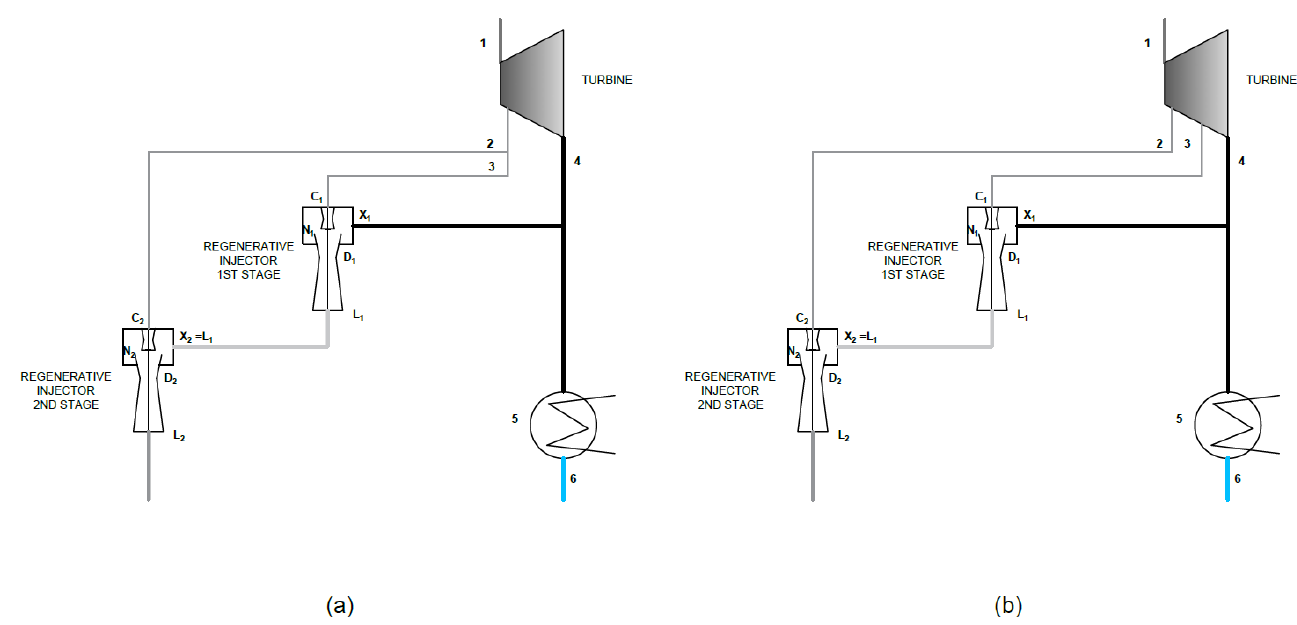
Figure 2. A thermal flow diagram of a two-stage steam jet injector driven by ( a ) the same bleed; ( b ) two different bleeds.